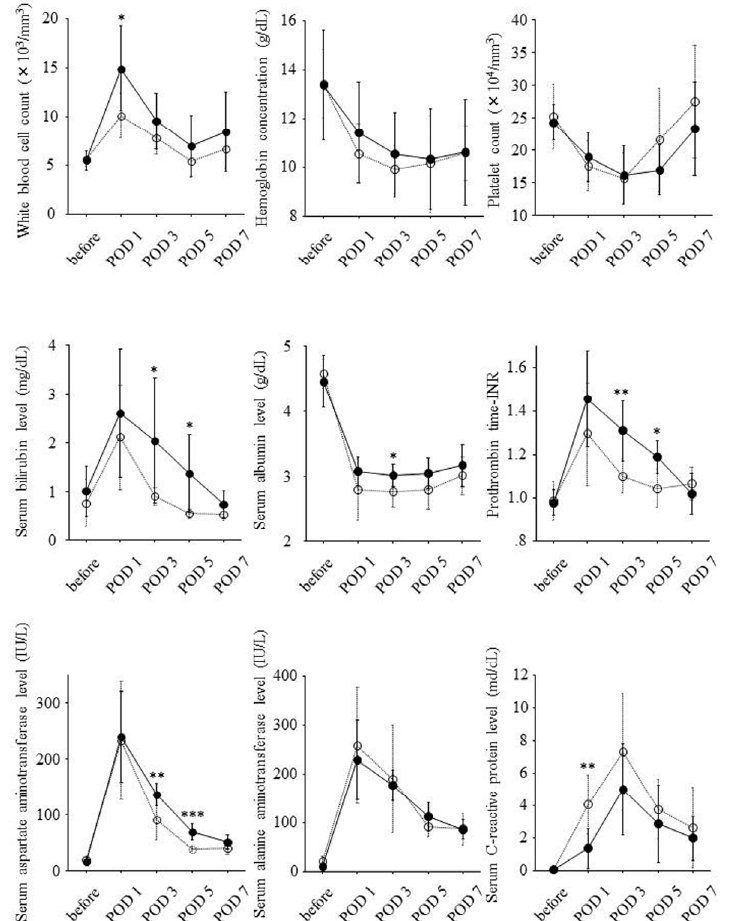
Ratio of liver volume on POD 14 to liver volume on POD 0 was correlated with white blood cell counts on POD 1 ( r = 0.63, p = 0.007), prothrombin time-INR on POD 3 ( r = 0.62, p = 0.009) and POD 5 ( r = 0.72, p = 0.010), and serum aspartate aminotransferase levels on POD 3 ( r = 0.71, p = 0.002) and POD 5 ( r = 0.67, p = 0.015). On the other hand, serum C-reactive protein levels on POD 1 were inversely correlated with ratio of liver volume on POD 14 to liver volume on POD 0 ( r = − 0.62, p =